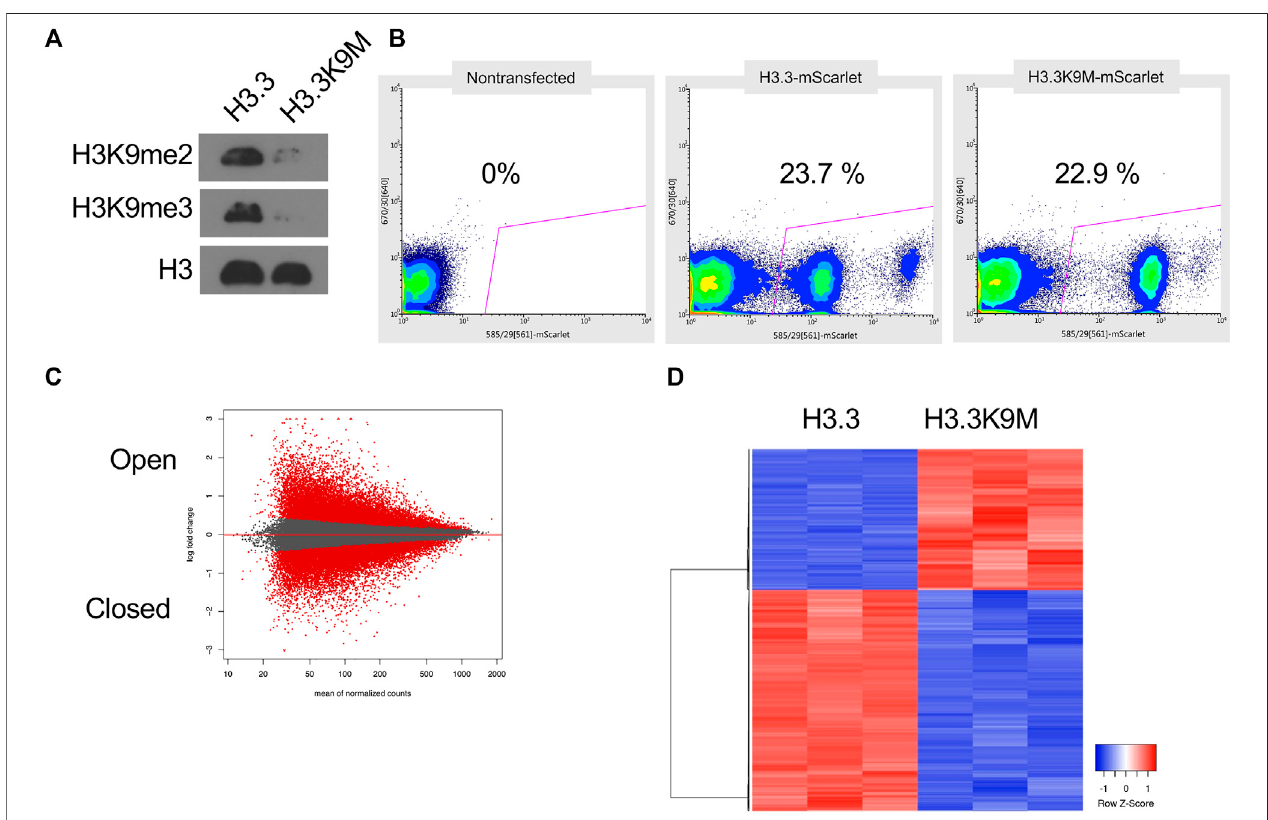
FIGURE 2 | H3.3K9M induces interferon response. (A) Western blot of acid-extracted histones in A375 cells expressing H3.3 WT or H3.3K9M transgenes. (B) Percentage of mScarlet+ cells sorted from a heterogeneous H3.3-mScarlet and H3.3K9M-mScarlet cell population using non-transfected cell as mScarlet control. (C) MA plot of H3.3K9M vs H3.3 (Peaks that change at FDR < 0.01 are colored red). (D) Top 1000 differentially expressed genes between H3.3-mScarlet and H3.3K9M- mScarlet (sorted by p -value adjusted). (E) Plot displaying Enriched signatures in H3.3K9M expressing A375 cells. Plot generated by GO Biological Process 2018 Enrichr(Mietal.,2013). (F) ATAC-seqpeaksthataredifferentiallymoreaccessibleinH3.3K9Mcells. (G) RNAseqnormalizedcountsforCD33insortedcells( n =4),( p < 0.0001).